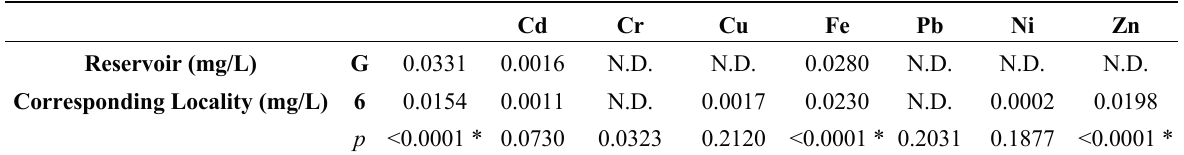
Table A8. Statistical variation between Reservoir G and its feeding Localities 6, 7, 13, 20, 24, 26,